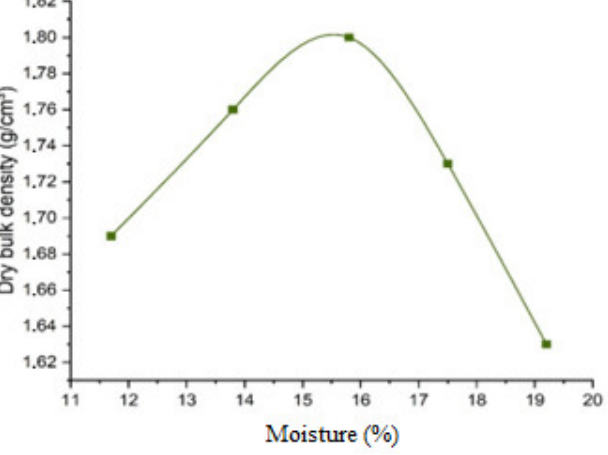
Figure 7. Soil compaction.